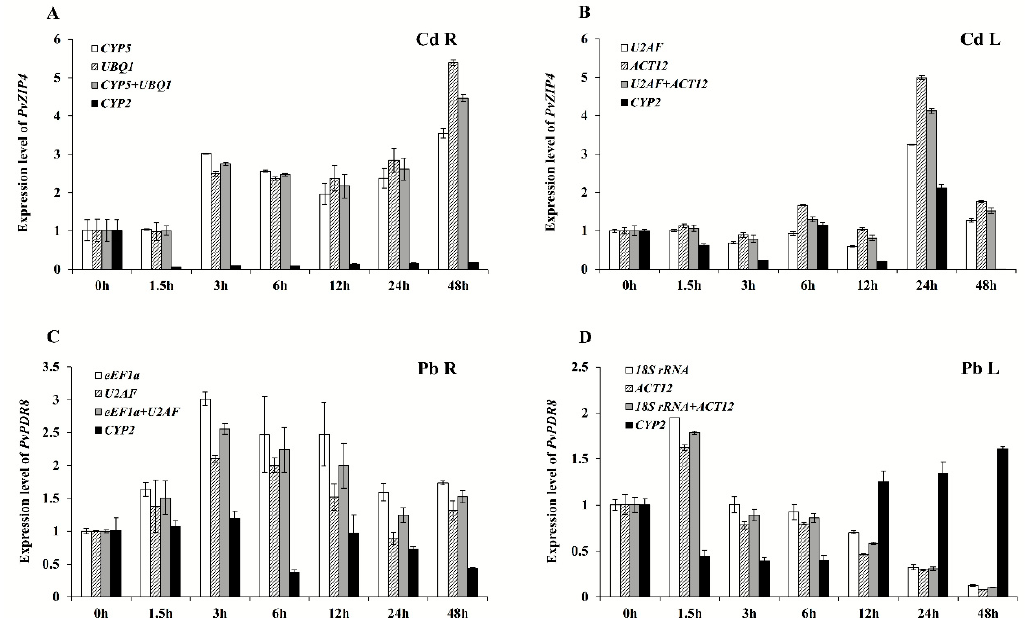
Figure 4. Expression levels of PvZIP4 and PvPDR8 in switchgrass leaves and roots under Cd and Pb stresses at different times. ( A , B ) represent expression levels of PvZIP4 . ( C , D ) represent expression levels of PvPDR8 . The relative expression levels were fold-change to time 0 h. R, L represent roots and leaves, respectively. Bars indicate standard errors.